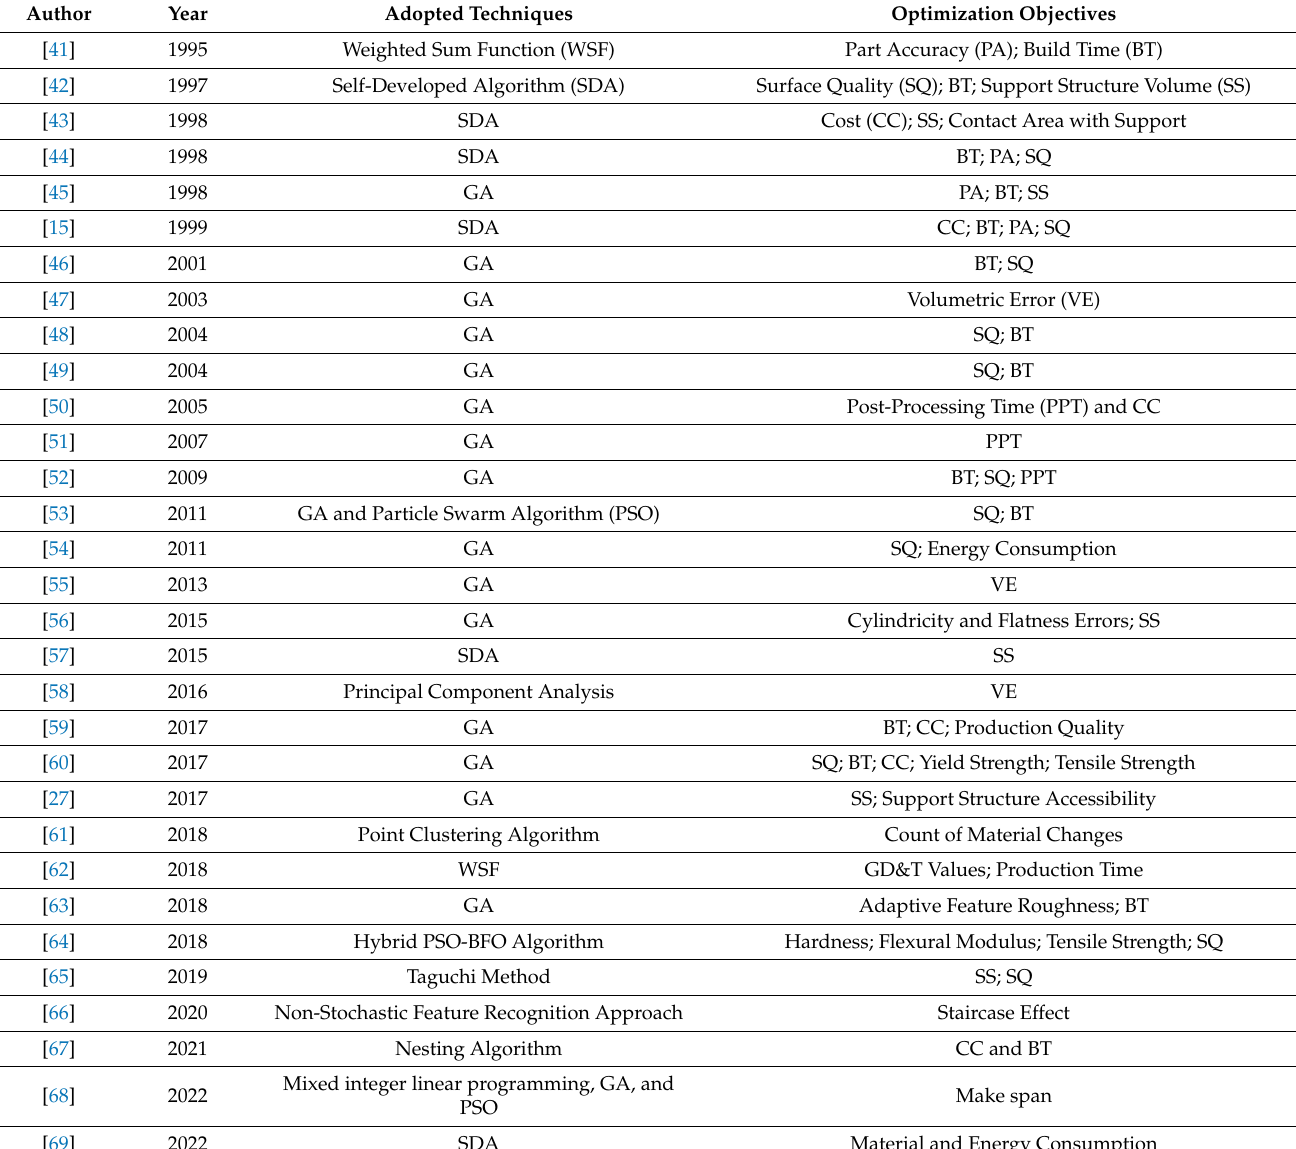
Table 1. Optimization approaches adopted to achieve the best build